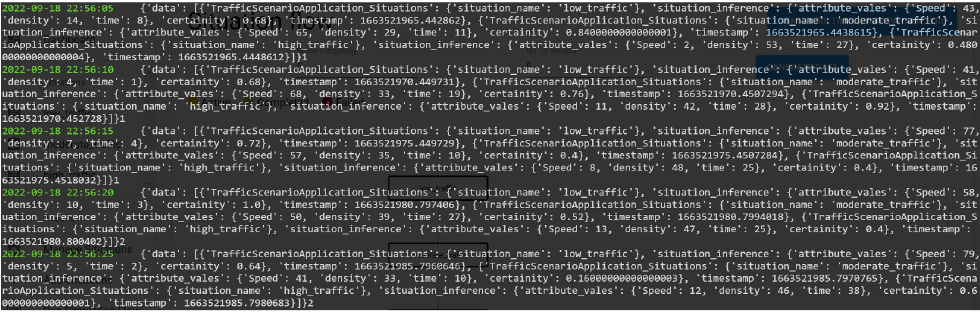
Figure 24. Data generated every 5 s.